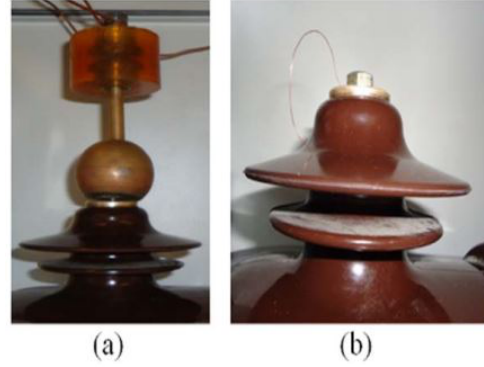
Figure 10. PD Sources ( a ) Voids in epoxy insulator ( b ) Surface discharge and corona